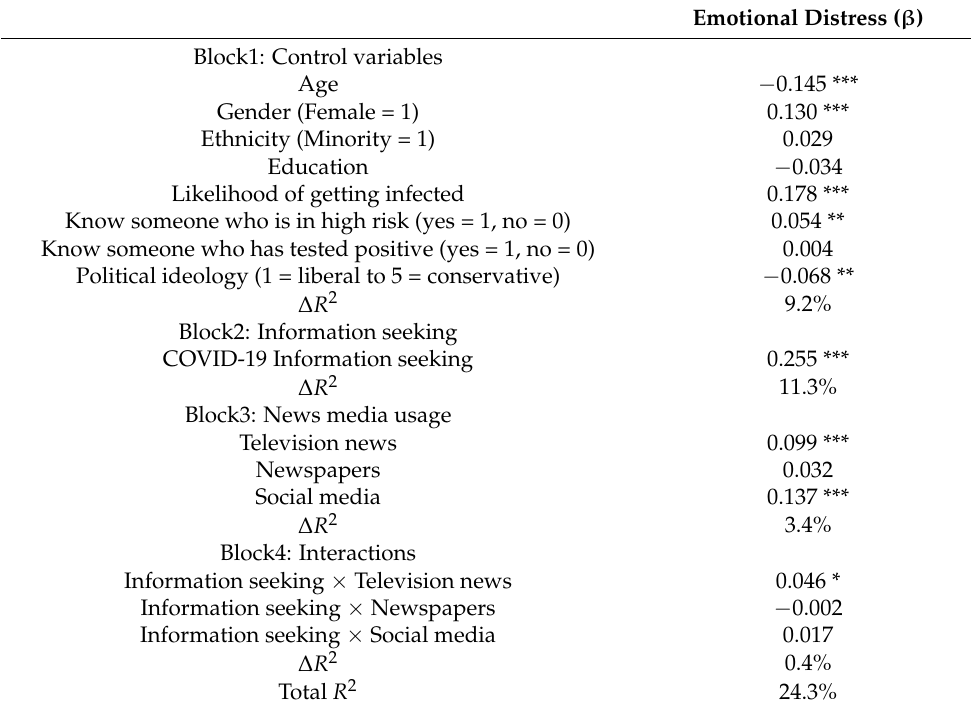
Table 2. Hierarchical regression analysis examining the relationships between COVID-19 information seeking, news media usage, and emotional